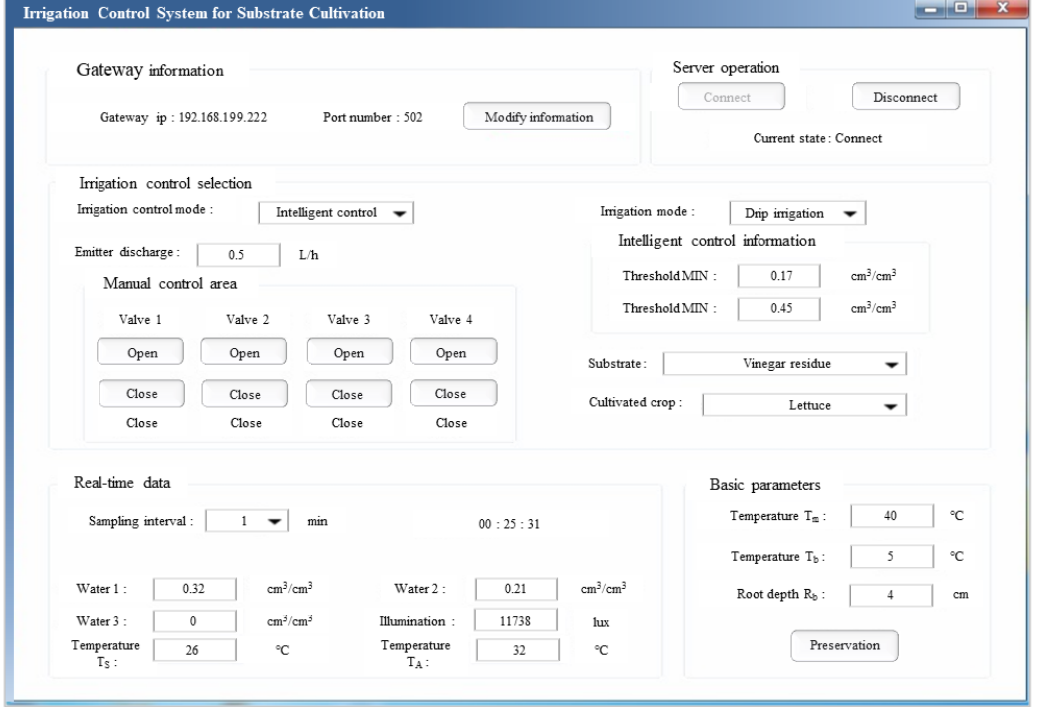
Figure 3. Control interface. Figure3. Control interface.